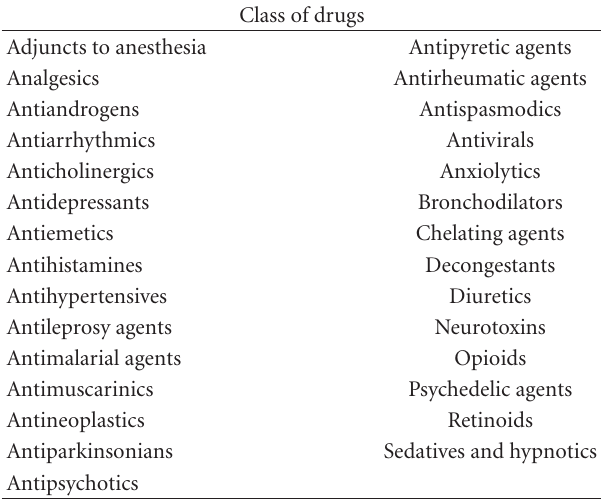
Table 1: Systemic medications that may cause both dry mouth and dry eyes